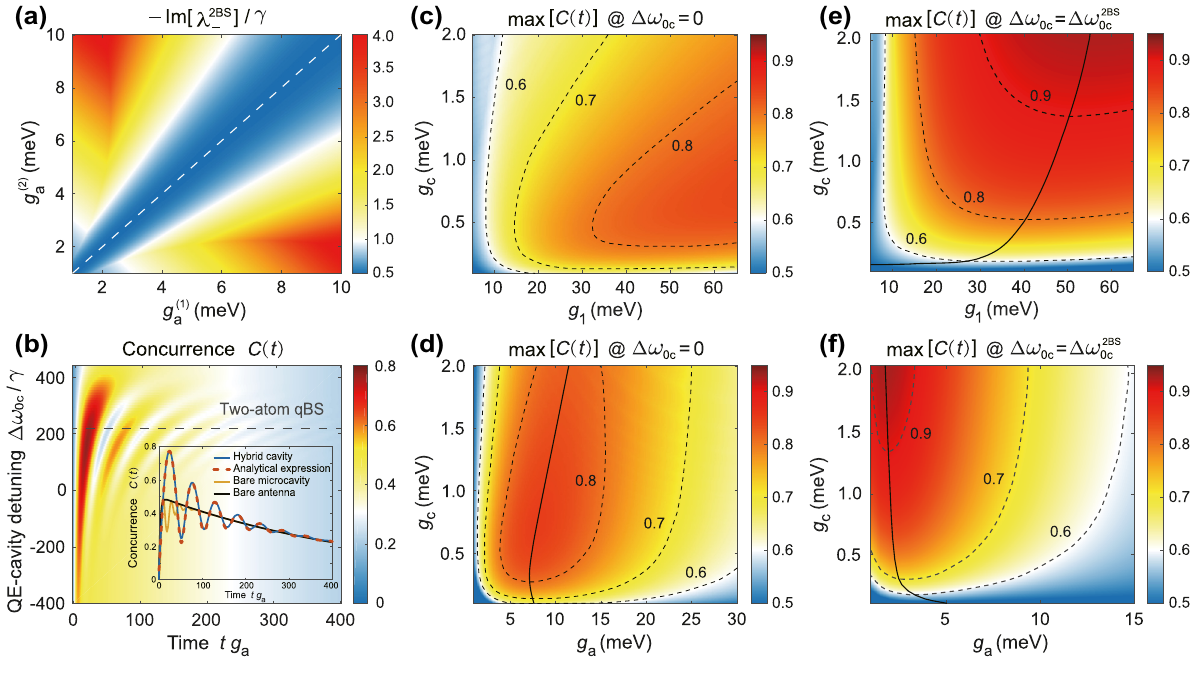
Figure 3: Two-atom qBS for spontaneous entanglement generation (SEG). and g (2) , normalized by the (a) The imaginary part of the eigenenergy of two-atom qBS as the function of QE-plasmon coupling rates g (1) a a . constant QE’s decay rate 𝛾 = 10 μ eV. The white dashed line traces the minimum decay. (b) Concurrence of SEG as the function of Δ 𝜔 0c Inset: Comparison of the concurrence of hybrid cavity with an approximate analytical expression. Concurrence of bare microcavity and plasmonic antenna are also shown for comparison. (c) and (d) Maximum concurrence max[ C ( t )] as the function of QE-photon coupling rate g c and plasmon-photon coupling rate g , QE-photon coupling rate g and QE-plasmon coupling rate g , respectively, in the condition of 1 c a = 0. (e) and (f) are the same as (b) and (c) but for the case of two-atom qBS with Δ 𝜔 = Δ 𝜔 2BS . The black solid lines resonant coupling Δ 𝜔 0c 0c 0c . The parameters of the resonant plasmon-photon hybrid trace the maximum concurrence with respect to the QE-photon coupling rate g c = 𝜔 = 1.618 eV, g = 5 meV, g = 0.6 meV, g = 20 meV, 𝜅 = 0.12 eV and 𝜅 = 0.5 meV ( Q ∼ 3000). The numerical cavity are 𝜔 a c a c 1 a c c calculations of concurrence are performed using QuTip [47], with system’s initial condition: one QE is in the excited state and the other is in the ground state, while the cavity fields are in the vacuum